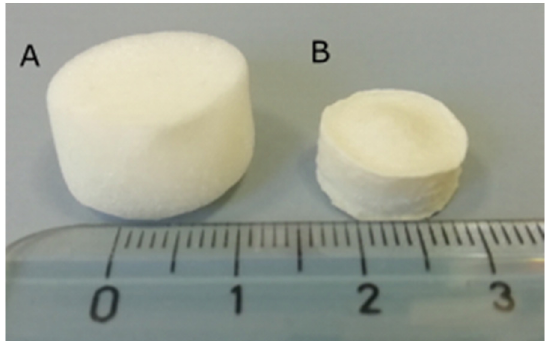
Figure 5. Illustration of pristine CS 1% scaffold ( A ) and cross-linked scaffold CS1_TPP1 2h ( B ).